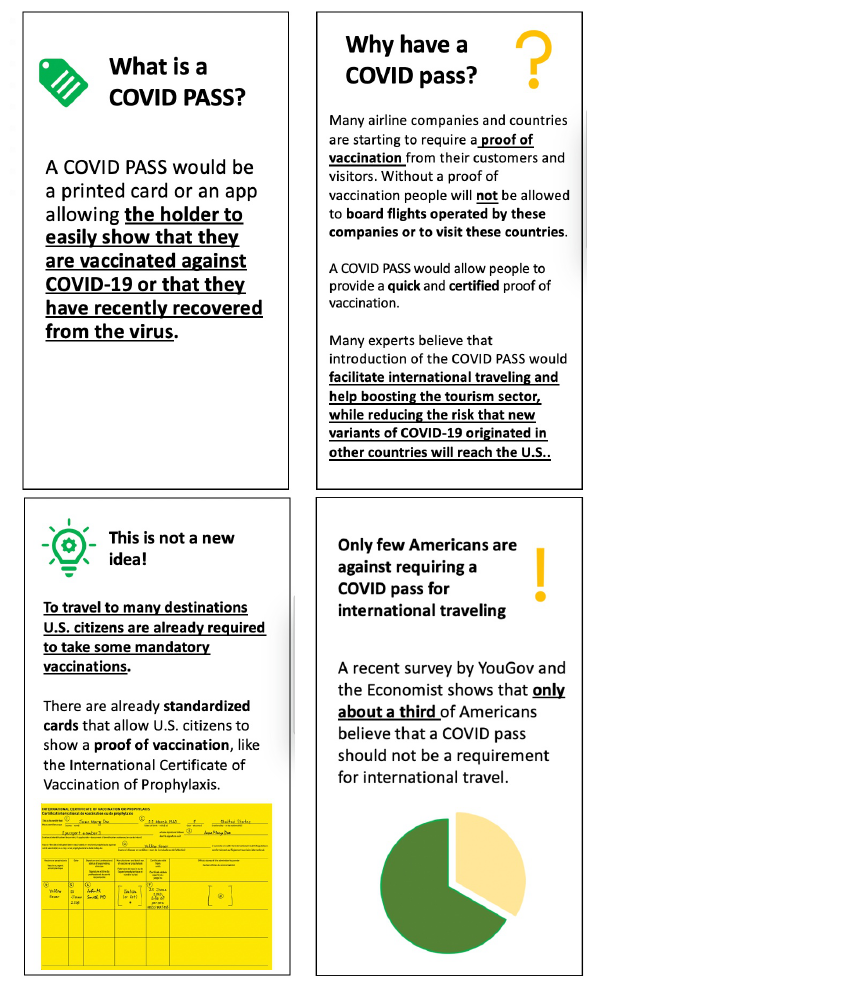
Figure 3. The top slides were shown to all participants. Respondents in the Control Group only saw the top slides. Respondents in the Status Quo Group also saw the bottom left slide. Respondents in the Peer Effect Group also saw the bottom right slide. Respondents in the Status Quo + Peer Effect Group saw all four